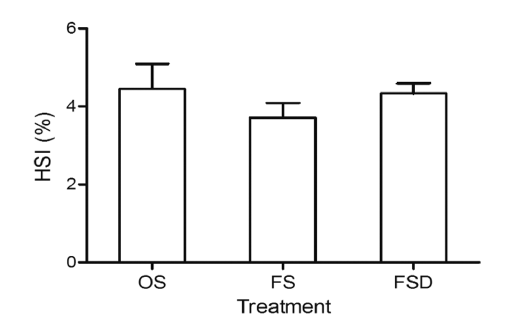
Fig. 3. Hepatosomatic indices (HSI) of whiteleg shrimp Lito - penaeus vannamei which were randomly selected for en- zyme analysis. Data are mean + SEM (n = 8). The values did not differ significantly between treatments (ANOVA, p = 0.4917, n = 8). See Table 1 for treatment